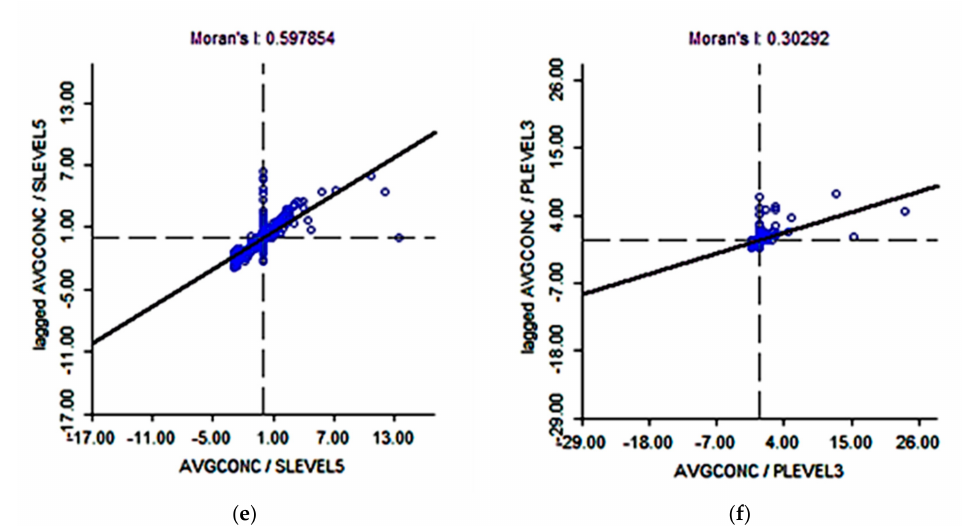
Figure 9. ( a – e ) Bivariate spatial autocorrelation of airborne lead concentrations (AVGCONC) (2007) and five levels (Natural Breaks classification scheme) of segregation (SLEVEL1-5). ( f ) Controlling for city-level racial differences and poverty